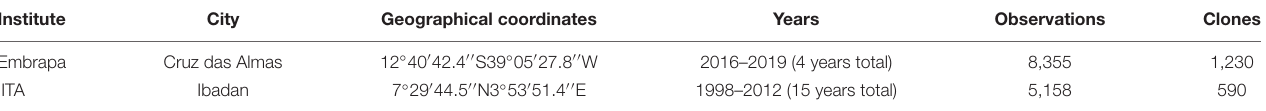
TABLE 1 | Experimental areas, cities, geographical coordinates, years, number of phenotypical observations, and clones. Institute City